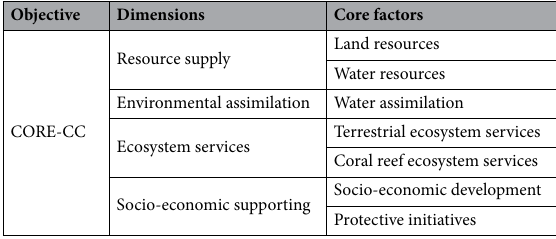
Table 1. Core factors of each dimension of